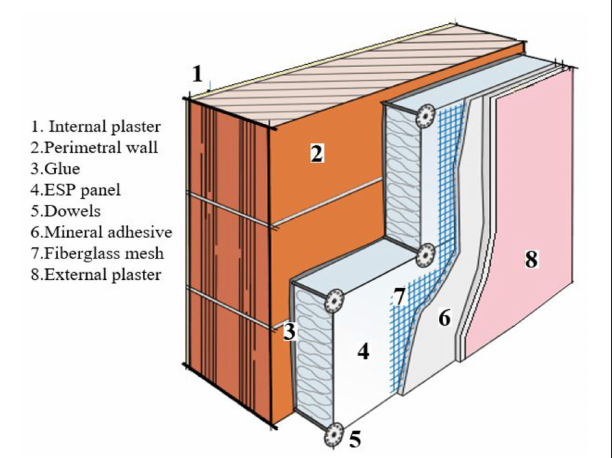
FIGURE 8 | Insulation system for the energetic upgrading of facades.